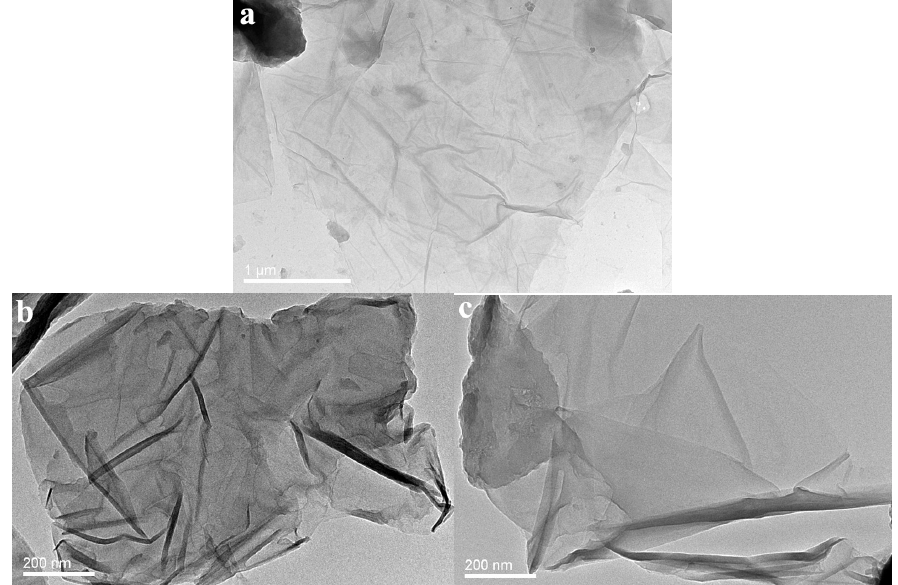
Figure 6. TEM images of ( a ) GO; ( b ) PANI/GO and ( c ) PANI/M-GO composites.